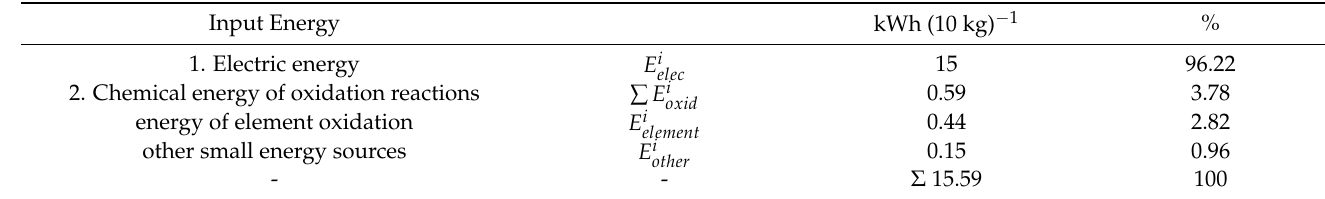
Table 2. Energy balance of